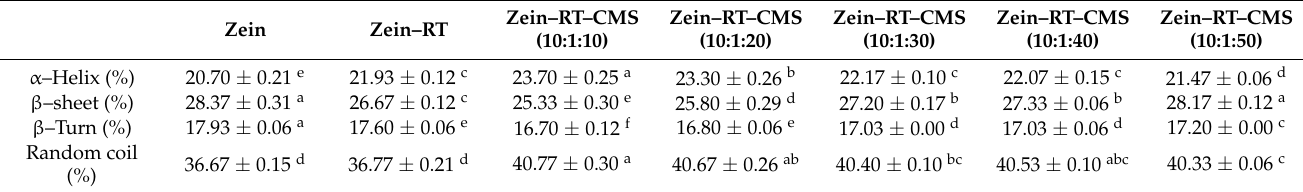
Figure 5. CD spectra of zein and composite particles. Table 1. Secondary structure contents of zein in composite nanoparticles.